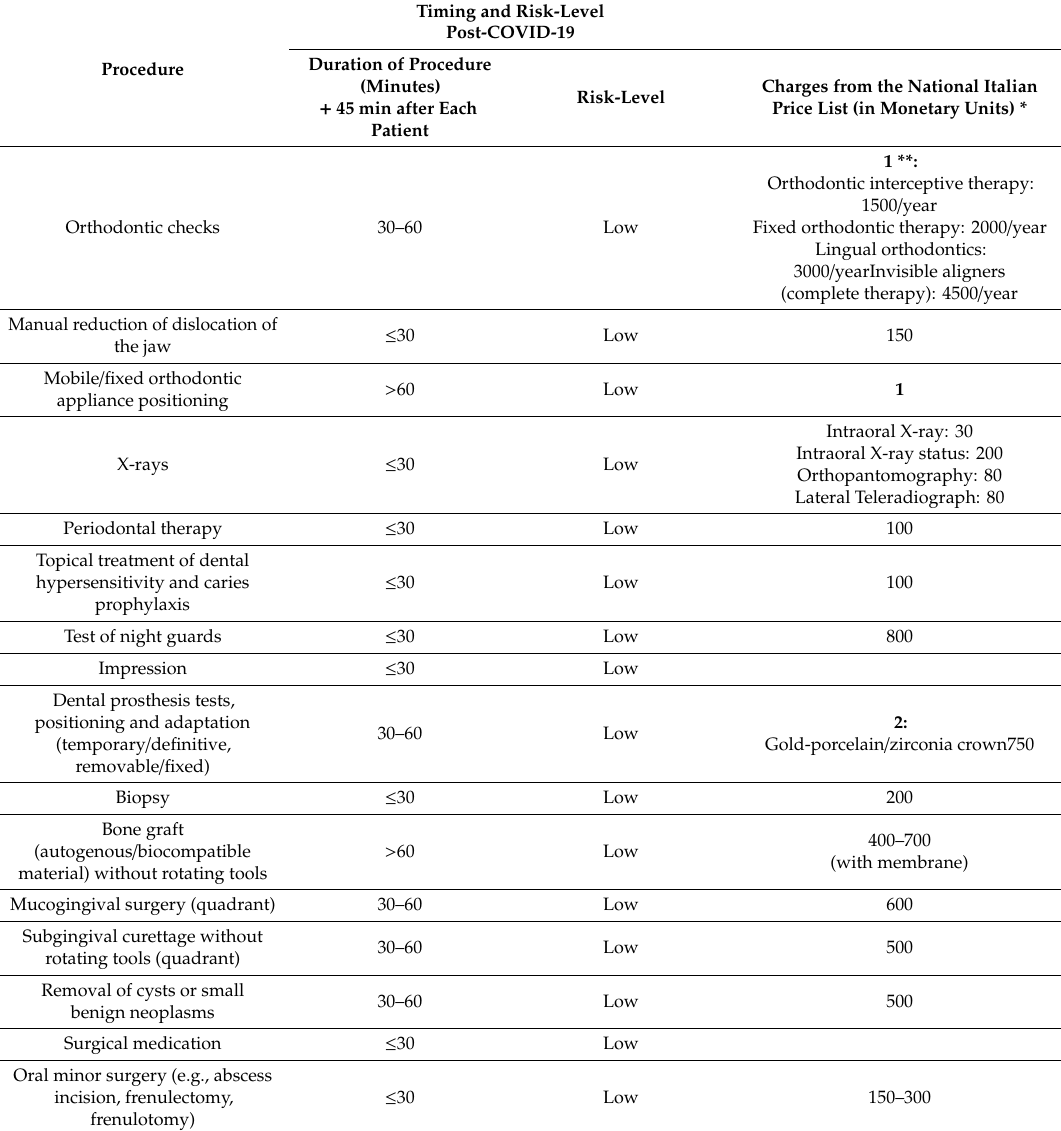
Table 1. Analysis of the most common dental and oral medicine